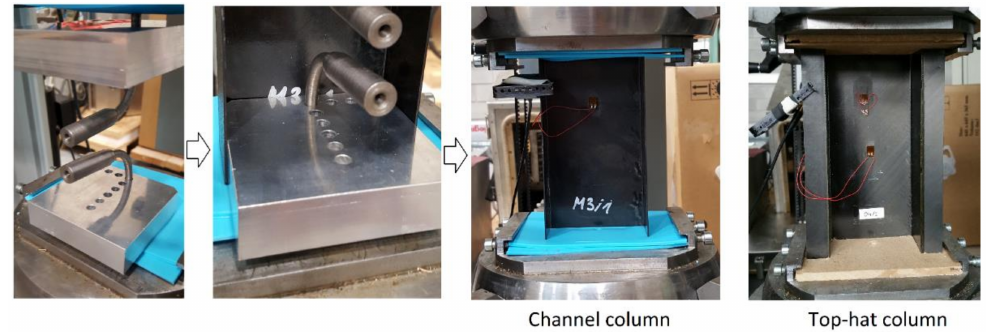
Figure 2. Experimental stand with mounted